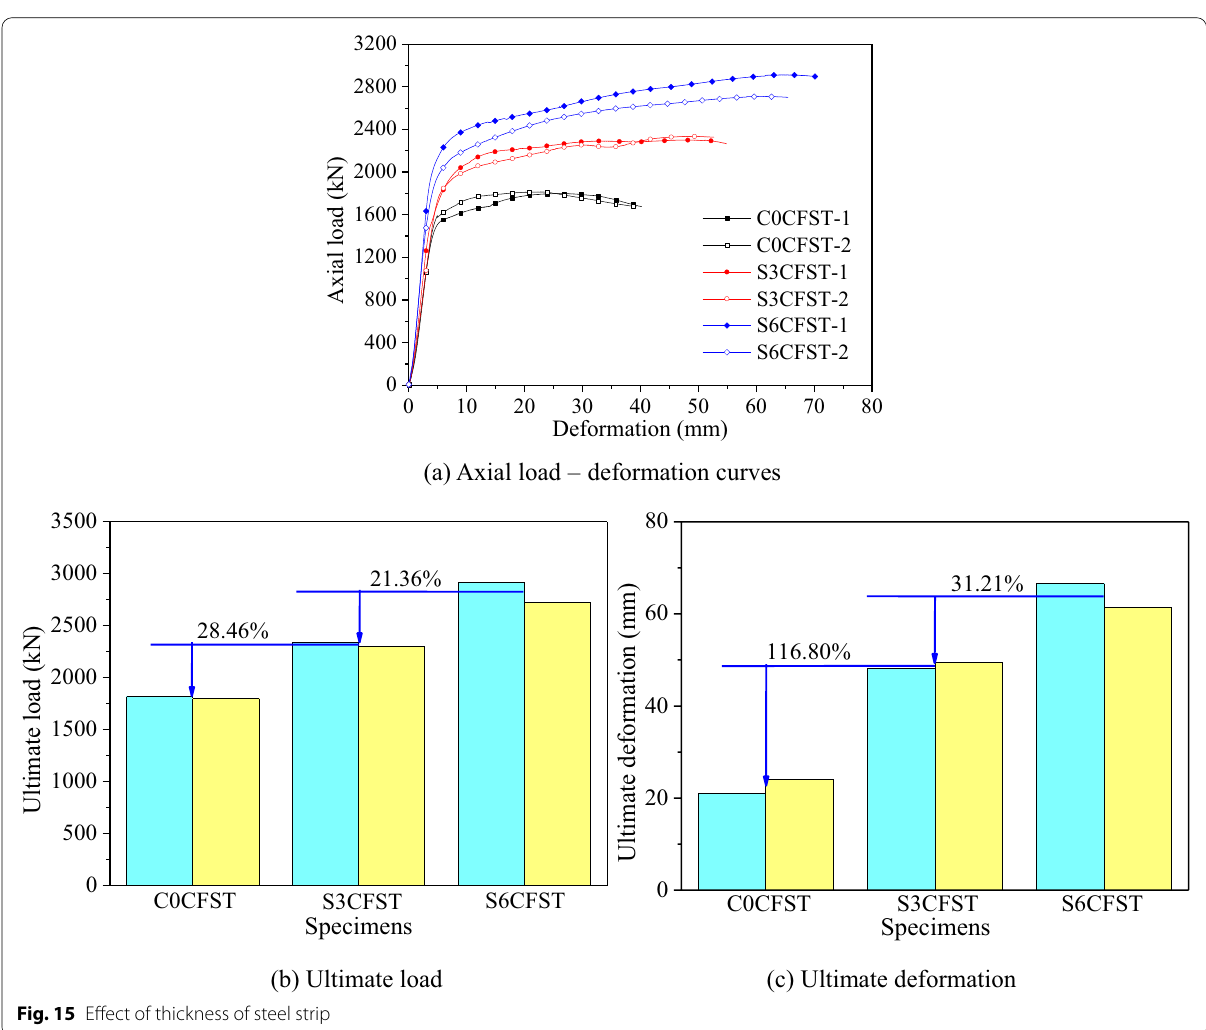
Fig. 15 Effect of thickness of steel